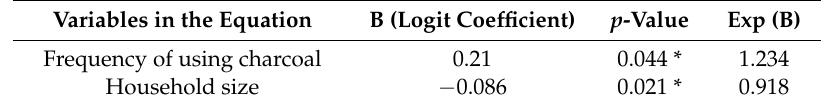
Table 4. Factors influencing the urban citizens to use charcoal for domestic purposes.